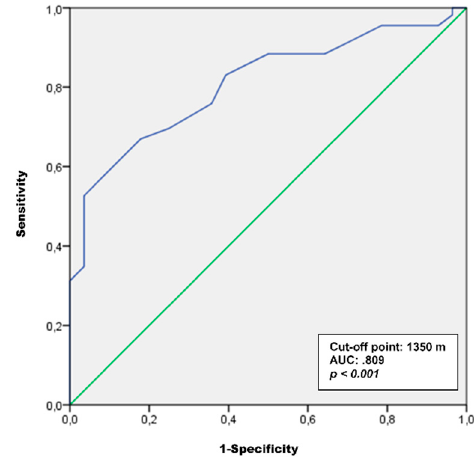
Figure 1. Receiver operating characteristic (ROC) curve analysis for active versus passive commuters by distance. Table 3. Cochran’s Q test values for the percentage of active commuters depending on the number of weekly active trips to and from school for participants below and above the threshold distance.